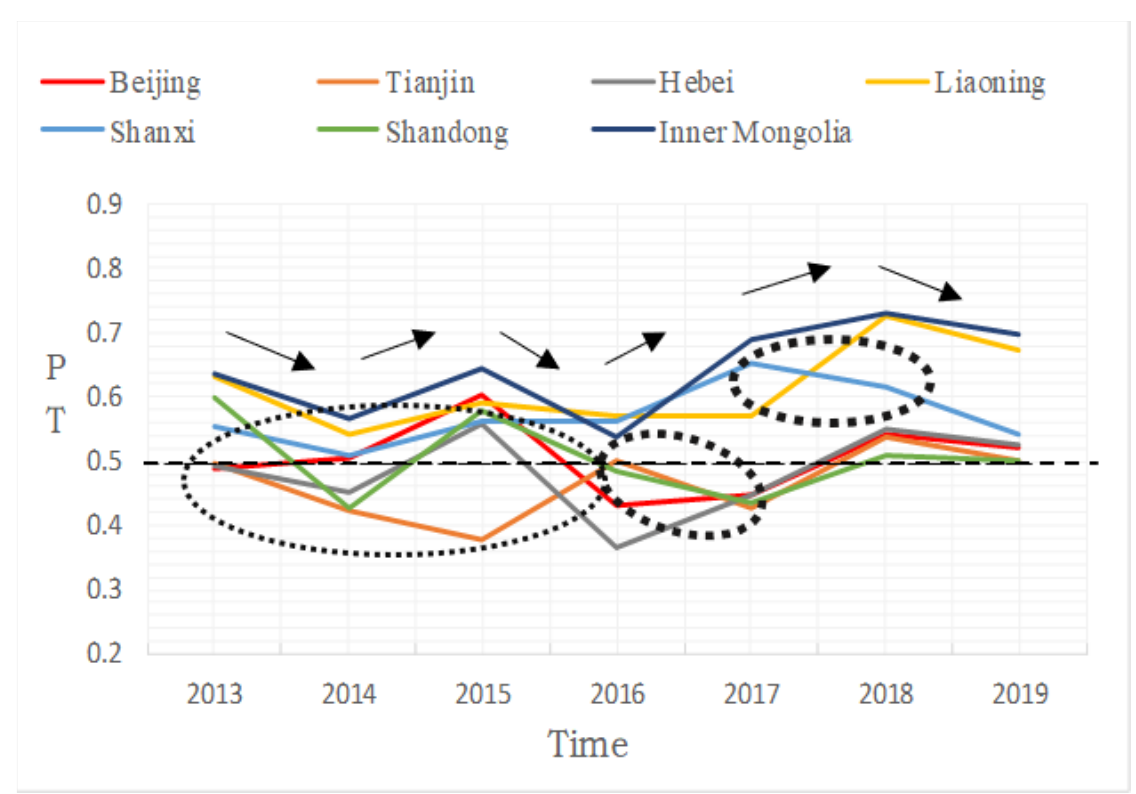
Figure 7. Timeseries of tolerance index.